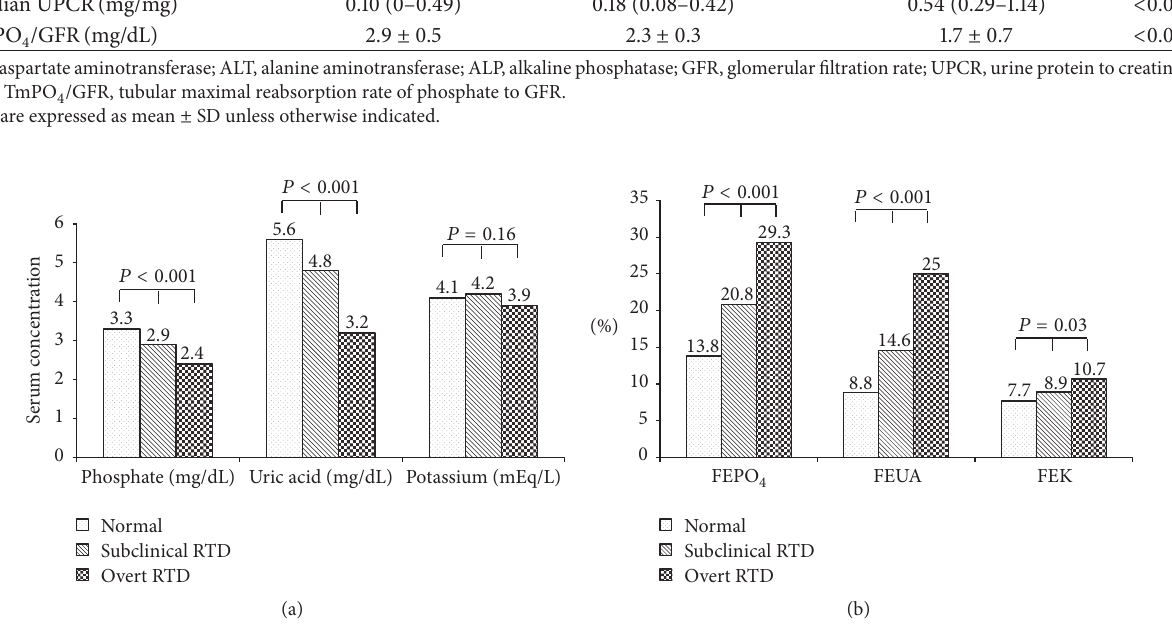
Figure 1: Serum phosphate, uric acid, and potassium levels among 3 groups are showed in (a). Fractional excretion of phosphate, uric acid, , fractional excretion of phosphate; FEUA, fractional excretion of uric acid, and FEK, and potassium among 3 groups are showed in (b). FEPO 4 fractional excretion of potassium